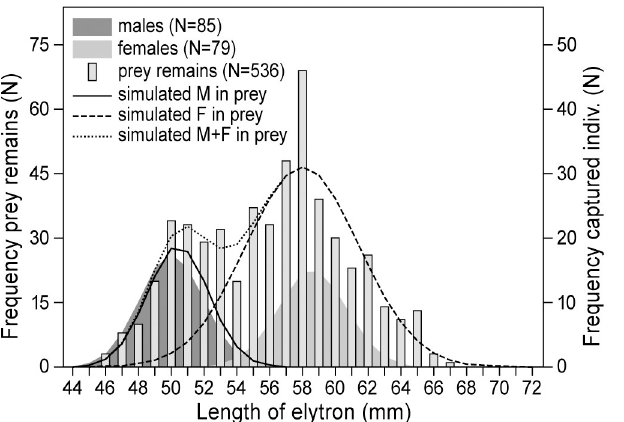
Fig 2. Frequency distributions of elytra of captured male (N = 85) and female (N = 79) desert locusts. Superimposed are frequency distributions (bars) of elytra (N = 536) recovered beneath kestrel plucking posts, separated into two complementary normal distributions (males solid line and females broken line). The dotted line is the sum of the male and female normal distributions. The distribution of lengths of elytra from captured locusts was significantly bimodal, P = 0.012